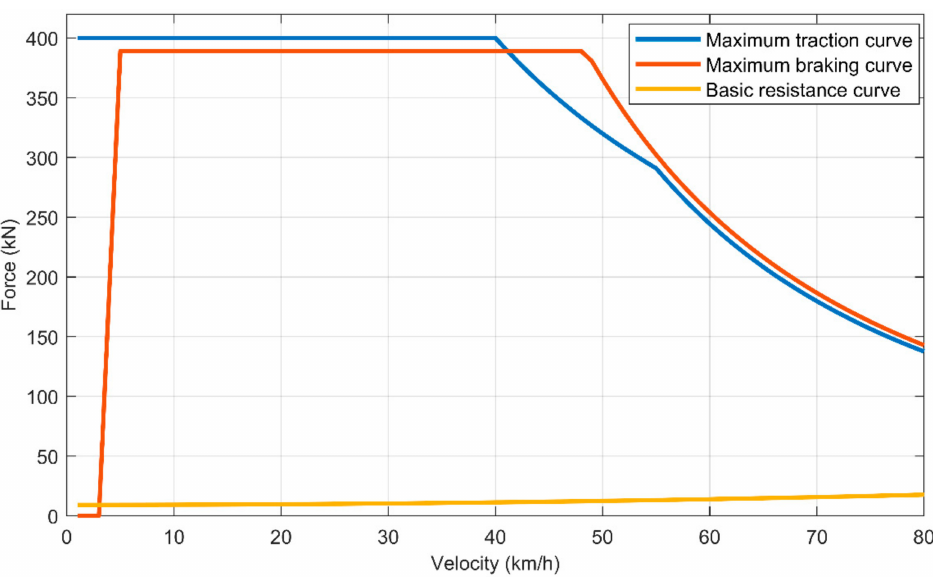
Figure 2. External characteristic curve of traction force and braking force.